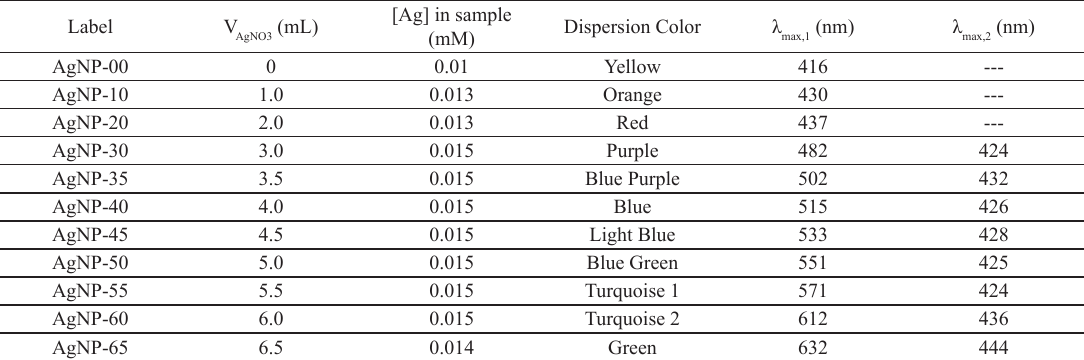
Table 1. Silver concentrations [Ag] of different colloidal dispersions prepared with different volumes of AgNO (λ ) and secondary (λ max,1